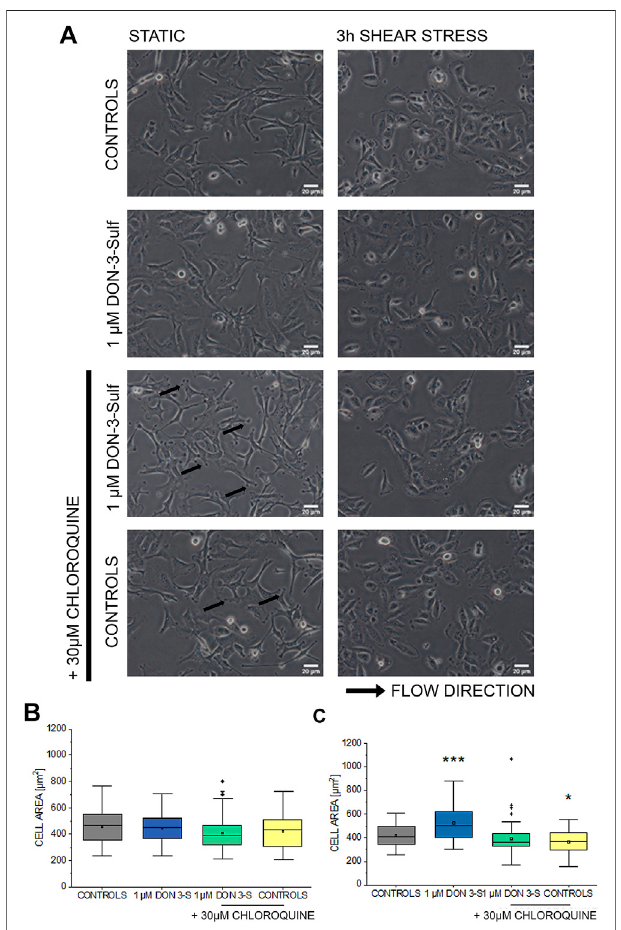
FIGURE 4 | Response of T24 to shear stress stimulation. (A) Bright fi eld appearance of T24 cells after incubation with 1 µM DON-3-Sulf and 30 µM chloroquine (CQ). (B) Quanti fi cation of cell area in static conditions and (C) after biomechanical stimulation. Morphometric data are mean of n (cid:1) 45 cells randomlyquanti fi edfrom three independentcell preparations. * indicates signi fi cant difference in comparison to controls at the Student ’ s t -test (*: p ≤ 0.05; ***: p ≤ 0.001; scale bar: 20 µm).